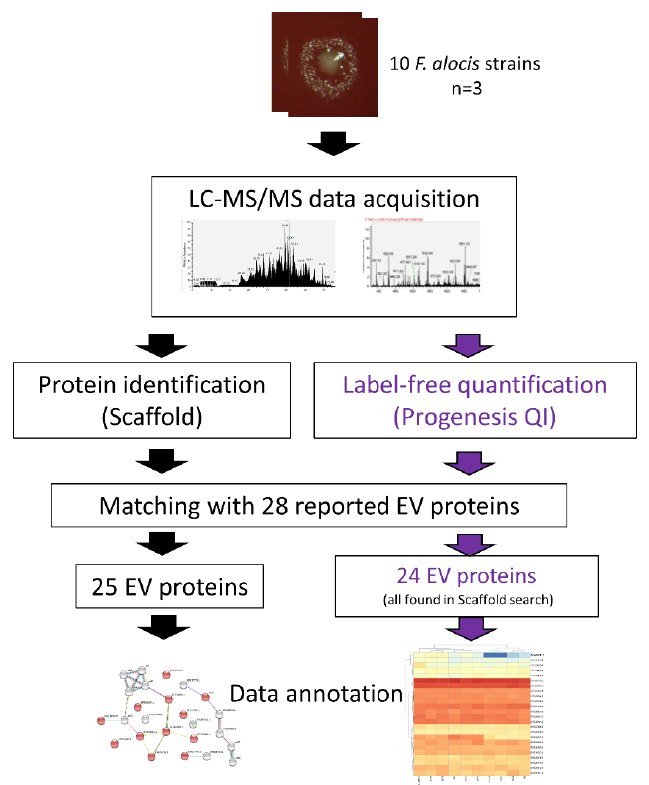
Figure 1. A schematic overview of the study design of the present work. The 28 EV proteins identi- fied in the F. alocis reference strain ATCC 35896 and reported on previously [21] were assessed for predicted protein – protein interactions and expression levels in the reference strain and in nine ad- ditional, less-characterized F. alocis clinical isolates. A colony from F. alocis strain 624B-08U is shown at the